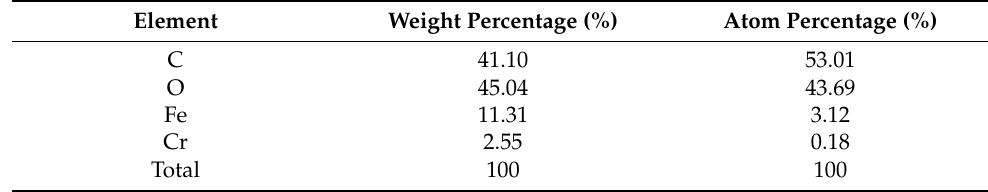
Table 4. The SEM–EDS analysis results of 8%Fe 3 O 4 @MMC adsorbent after adsorption.